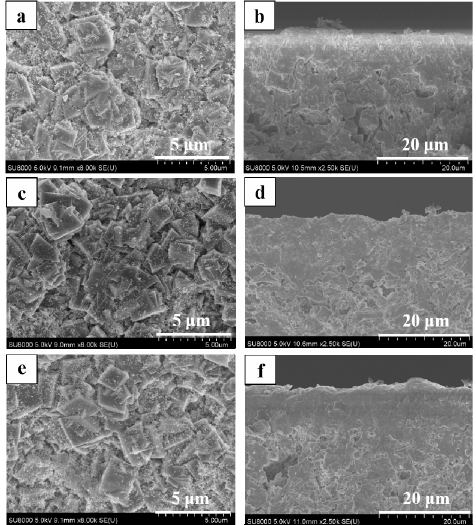
Figure 7. Surface and cross-sectional SEM images of high silica SSZ-13 zeolite membranes with different TMAdaOH/SiO 2 ratio, ( a , b ) M-7, TMAdaOH/SiO 2 = 0.05; ( c , d ) M-4, TMAdaOH/SiO 2 = 0.10; ( g , h ) M-8, TMAdaOH/SiO 2 = 0.15.